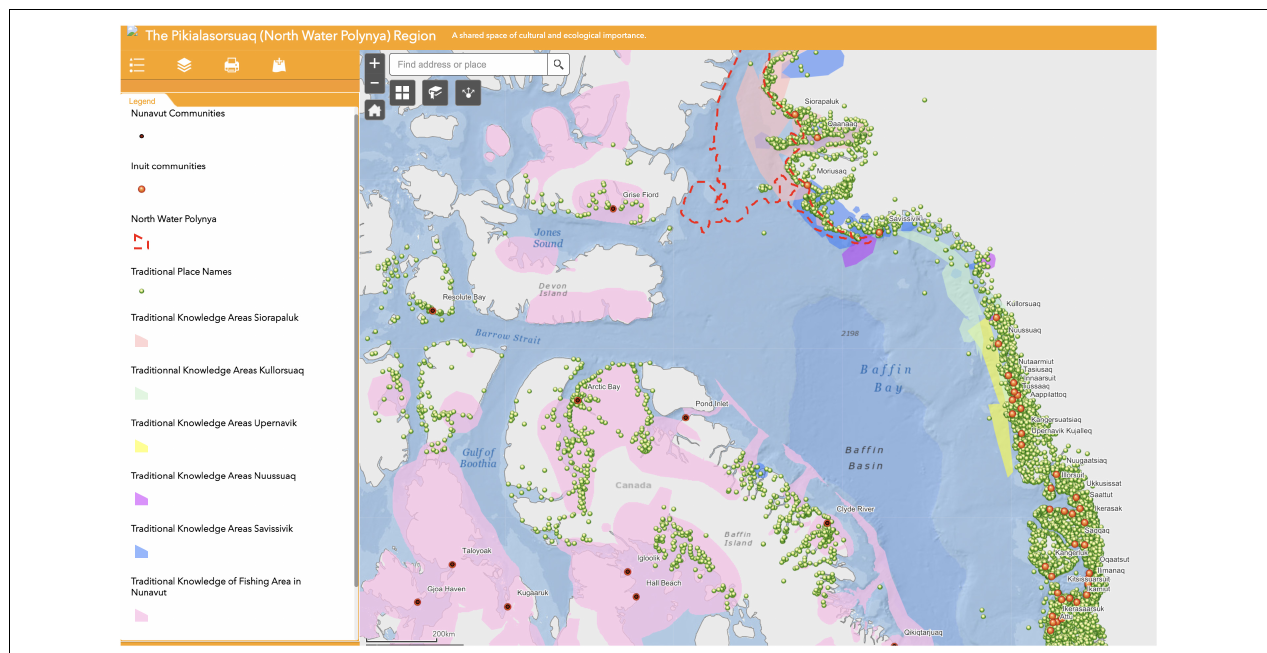
FIGURE 4 | The Pikialasorsuaq (North Water Polynya) Planning Tool allows users to upload and navigate through different layers to develop an understanding of how different activities may impact the polynya. For example, this screenshot displays overlap between narwhal habitat and undiscovered oil in the Arctic. Screenshot from https://panda.maps.arcgis.com/apps/webappviewer/index.html?id=35081265064a460da83e89d43c041f5c on June 11,